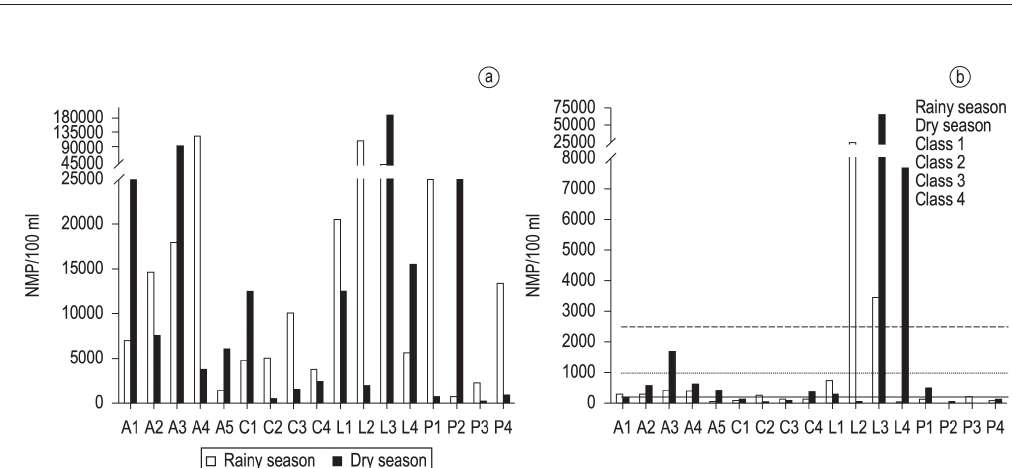
Figure 4. Variation of total coliforms (a) and thermotolerant (b) in Araquá, Capivara, Lavapés e Pardo Rivers in rainy and dry season and the rivers classification limit (class 1,2, 3 and 4) according to CONAMA